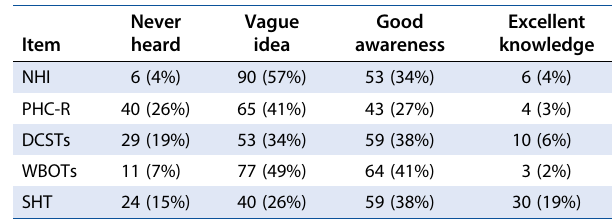
Table 1: Students ’ awareness of the roles of the family physician ( n = 157) Role